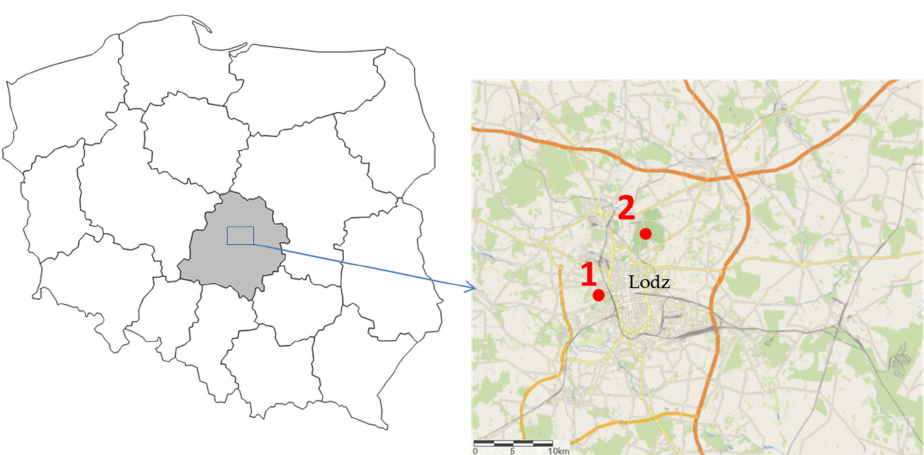
Figure 1. Study area with the spatial location of the study sites (1—urban parkland; 2—mature deciduous forest). The map of Poland was created with STATISTICA software [41] using the Maps add-on (v. 3.1.85). The map with the pointed study sites was made by applying QGIS 3.16.3 Hannover software (https://www.qgis.org/, accessed on 1 September 2022). Both maps were merged and modified in GIMP v. 2.10.30 (GIMP Development Team 2022: http://gimp.org, accessed on 1 September